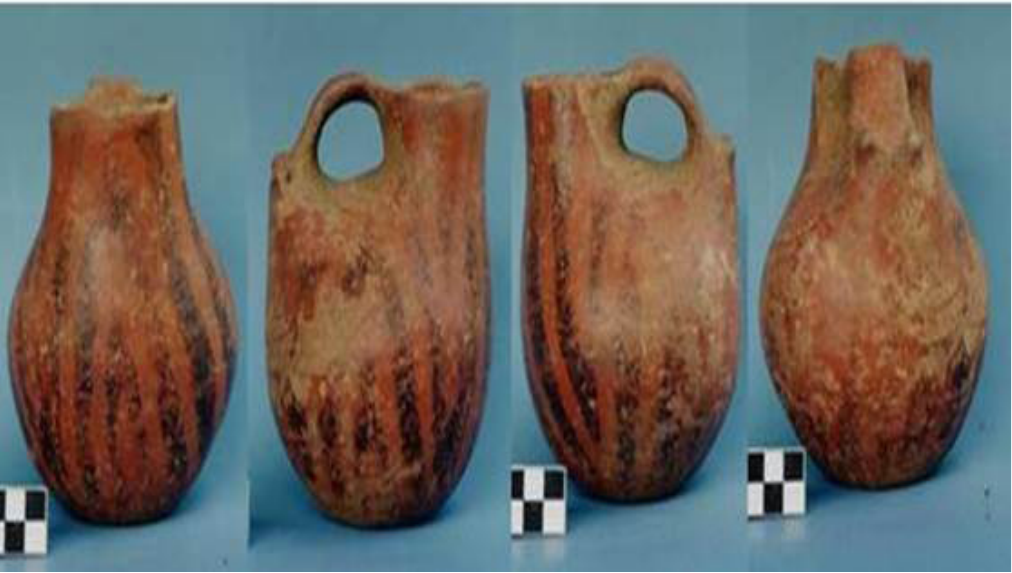
Figure 1. Example of morphological group 15, “jars” category (Adán & Alvarado, 1999, p. 258, Fig. 1) from the Museum of Valdi- via, Chile (N° A0514); courtesy of Verónica Reyes